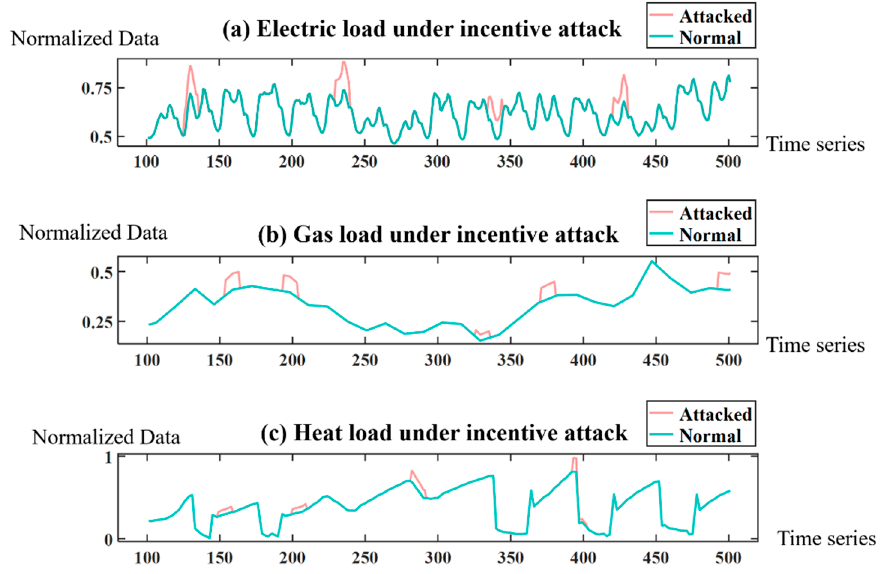
Figure 17. Attack process for certain load samples.